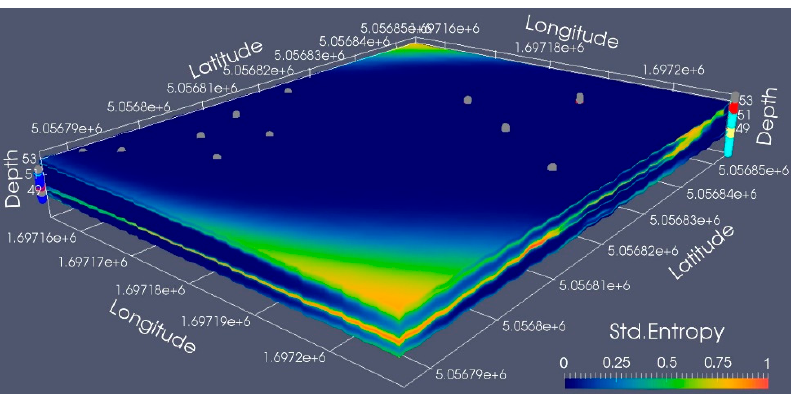
Figure 6. Markovian-type Categorical Prediction (MCP) 3D simulation on 91 layers every 5 cm in depth from 53 to 48.5 m a.s.l.; cross sections A, B, C of MCP 3D simulation and simplified stratigraphies of the 13 boreholes.